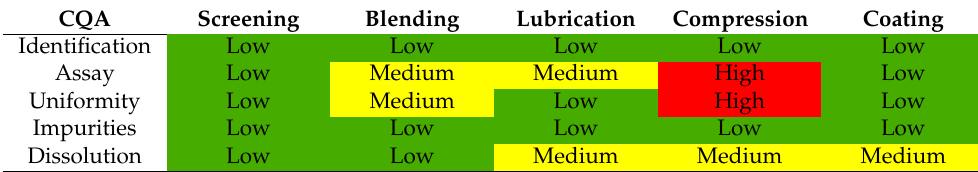
Table 8. Preliminary hazard analysis in risk assessment.